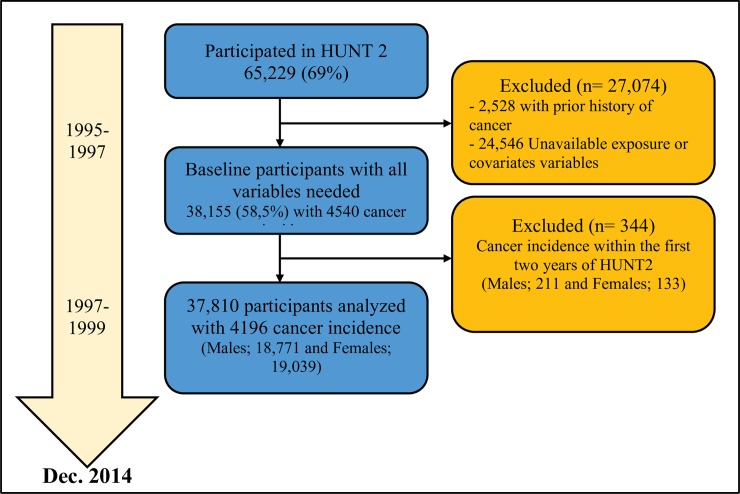
The study flowchart of inclusion over the period.